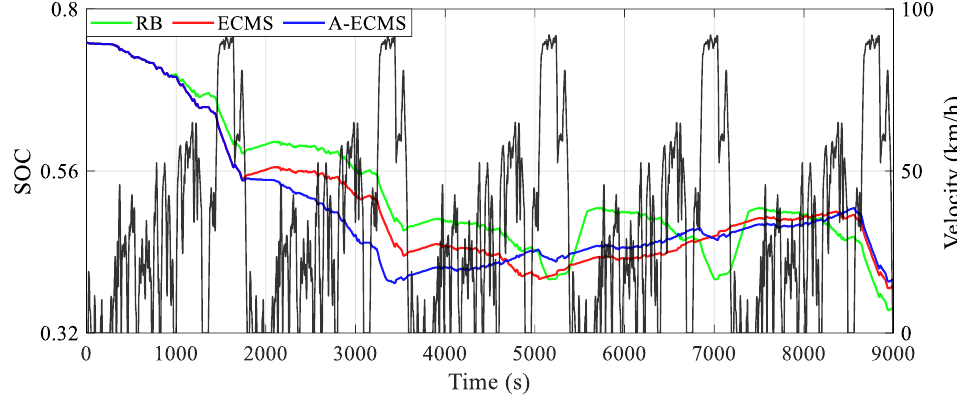
Figure 8. Curves of battery SOC using different